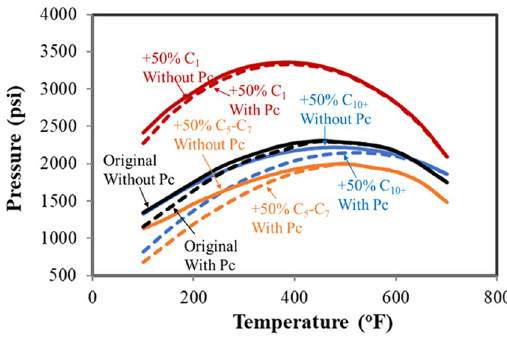
Figure 4. Pressure-temperature phase envelopes of different fluid